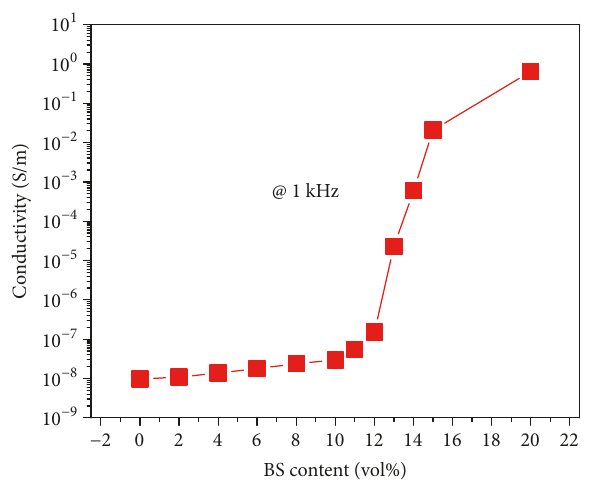
Figure 7: Conductivity variation of the Bi 2 Se 3 /PVDF nanocompos- ite films with respect to the BS (Bi 2 Se 3 ) volume fraction, measured at room temperature and 1 kHz.